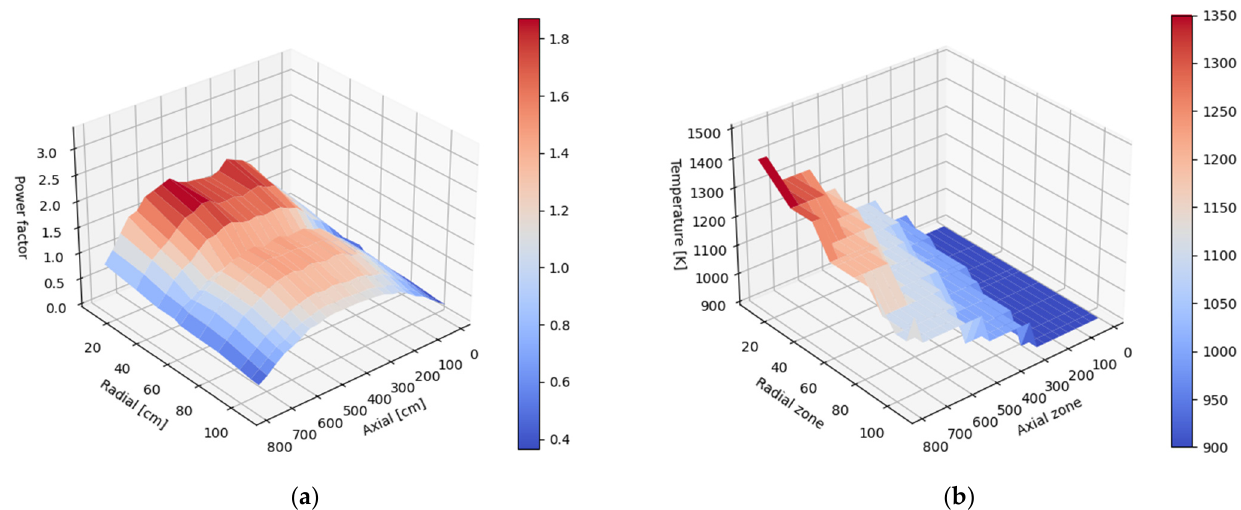
Figure 4. Power distribution ( a ) and temperature distribution ( b ) in fresh core calculated by MCB after the initial temperature and Xe concentration adjustment—both in the St_solid and St_struc cases.